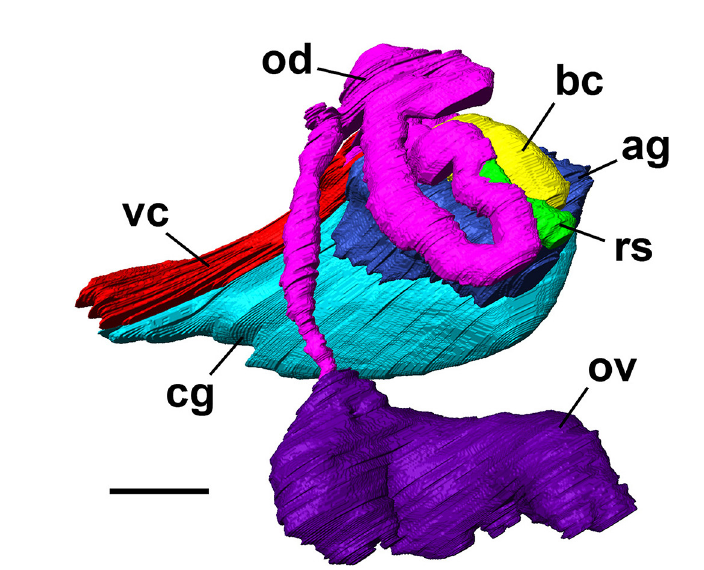
Fig. 14. Female genitalia of Obtusopyrgus farri sp. nov. µCT scans. Abbreviations: ag = albumen gland; bc = bursa copulatrix; cg = capsule gland; od = oviduct; ov = ovary; rs = receptaculum seminis; vc = ventral channel. Scale bar = 100